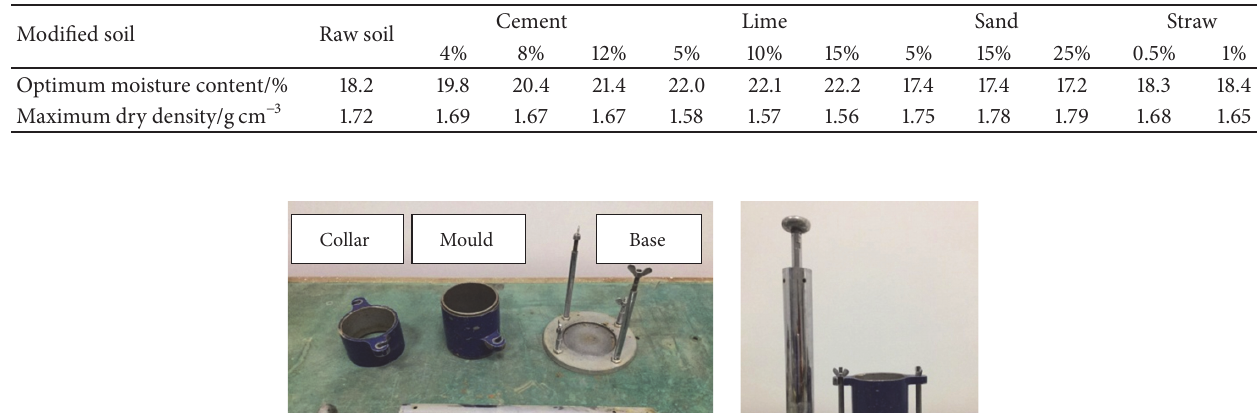
Table 2: OMC of raw soil and modified soil.